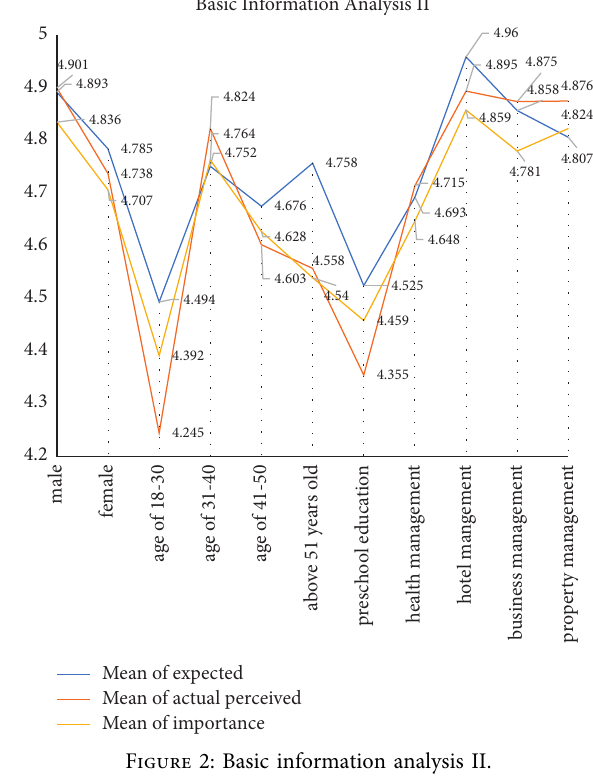
Figure 2: Basic information analysis II.